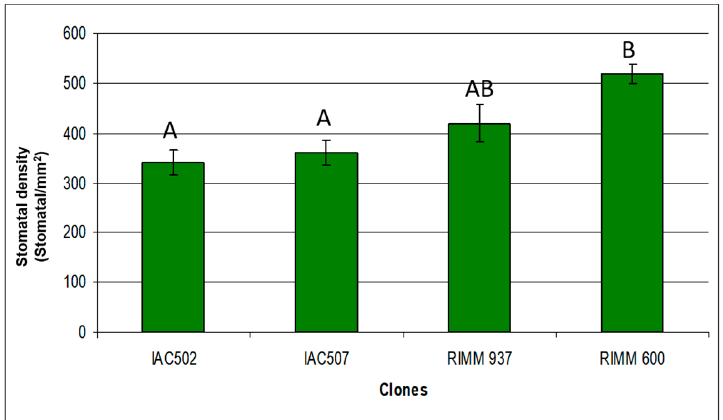
Figure 7. Average density of rubber tree clones (IAC502, IAC 507, RRIM 937 and RRIM 600). Means followed by the same letter do not differ, according to Tukey’s test, at 5% probability. Coefficient of variation: 15.80.